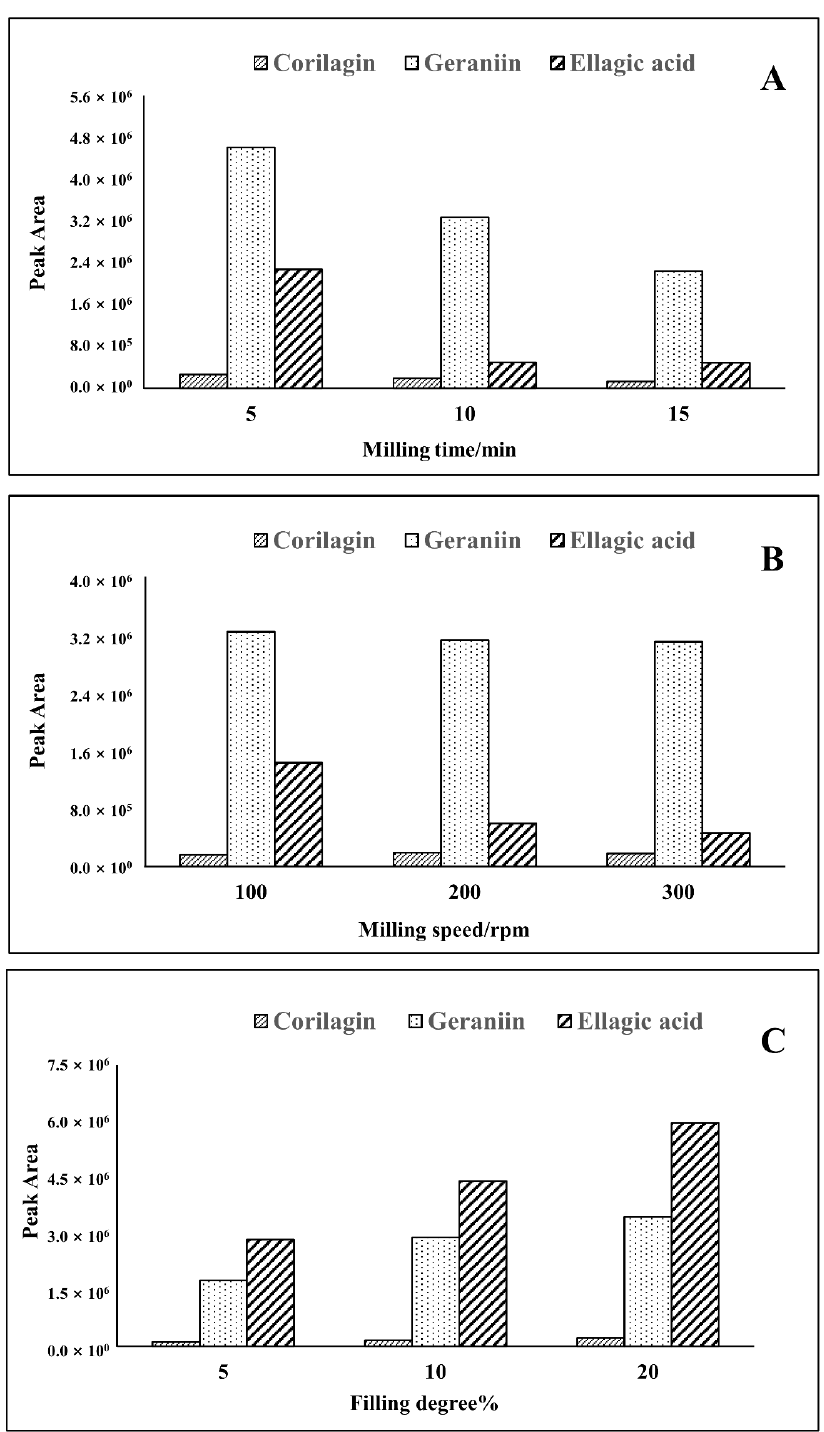
Figure 2. Effect of the MCAE procedure on the yield of ellagitannins and ellagic acid. ( A ) Effect of milling time; ( B ) Effect of milling speed; ( C ) Effect of filling degree.